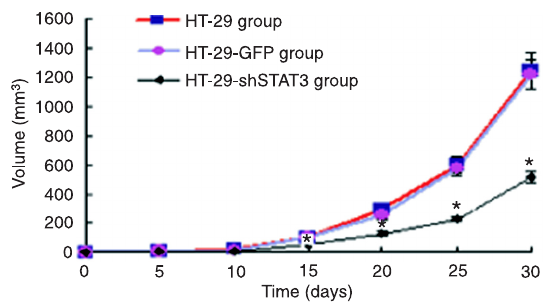
Figure 4. Change of tumor volumes in each group. * P < 0.05 vs HT-29 and HT-29-GFP groups (ANOVA).